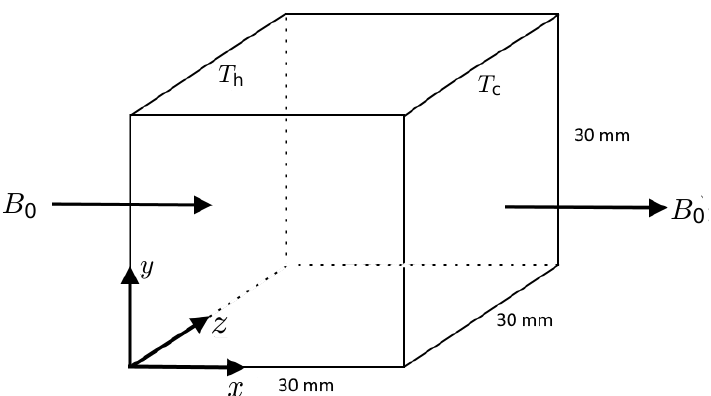
Figure 10. Schematic for the three-dimensional natural convection problem in the presence of a magnetic